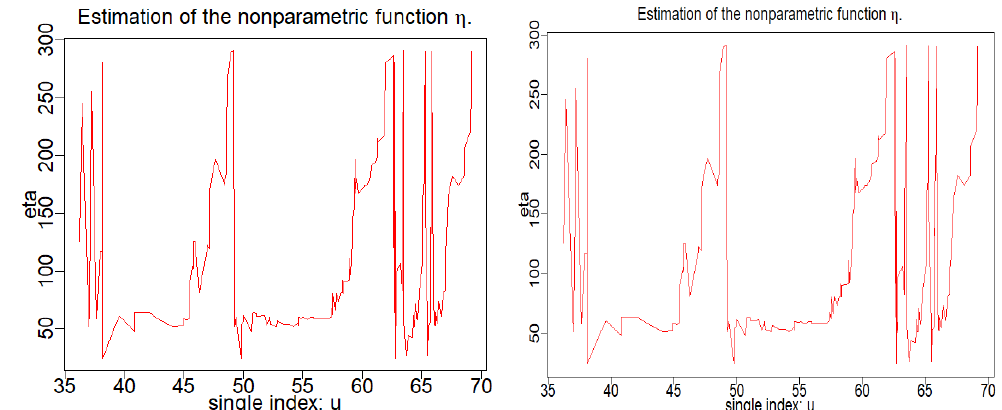
Figure 6. On the left plot: estimated non-parametric function ˆ η ( . ) , Gaussian case. On the right plot: estimated non-parametric function ˆ η ( . ) , logistic case.